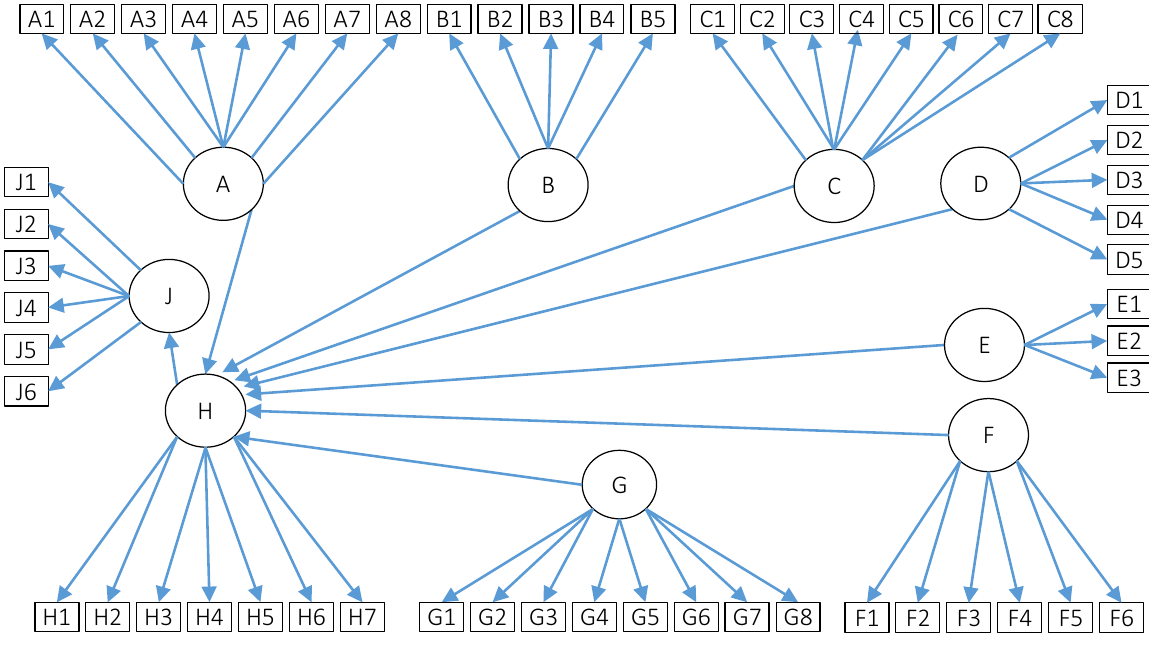
Figure 1. Path of the causality